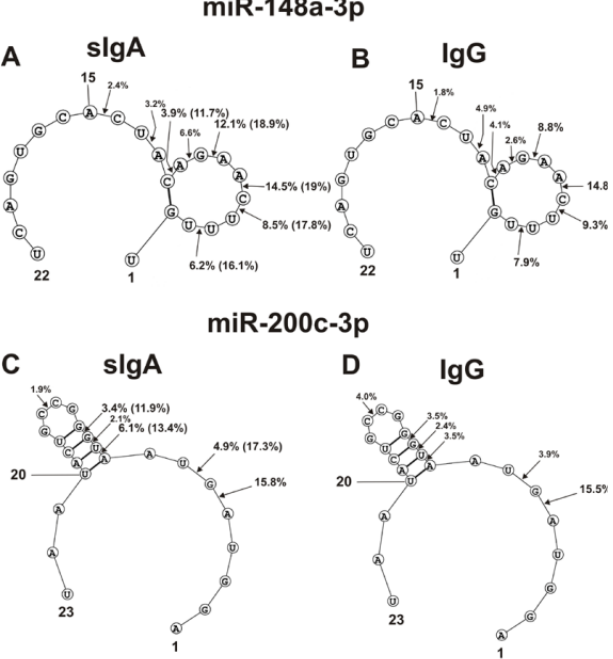
Figure 4. The average efficiencies of Flu-miR-148a-3p ( A , B ) and Flu-miR-200c-3p ( C , D) hydrolyzed by seven sIgAs ( A , C ) and IgGs ( B , D ) from human milk plasma, in all sites of their cleavage. The average percentages of microRNAs and positions of separation in different sites of microRNA hydrolyzed by antibodies are shown using spatial models of microRNAs. Values in parentheses indicate the efficiencies of microRNA hydrolysis at individual sites by some preparations, with an increased specific activity in relation to these sites. Numbers 1, 15, 20, 22 and 23 correspond to the terminal RNA nucleotides